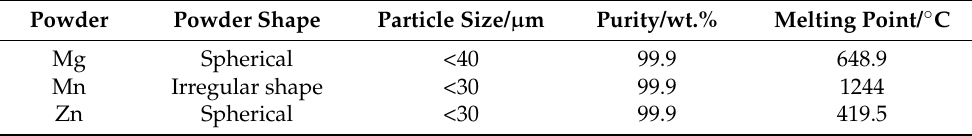
Table 1. Powder material parameters for the preparation of medical Mg-Mn-Zn